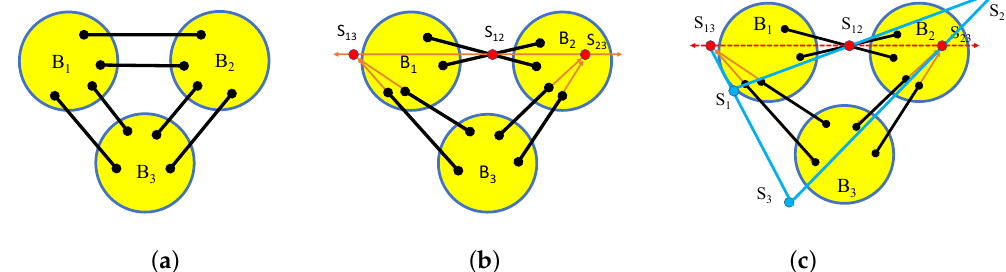
Figure 46. Three bodies joined in pairs are generically isostatic ( a ). The pairs of bars force relative centers of motion, and the condition for a non-trivial motion is that these relative centers are collinear ( b ). We have choices of the actual centers as projective points, provided they satisfy the geometric condition for the relative centers ( c ).